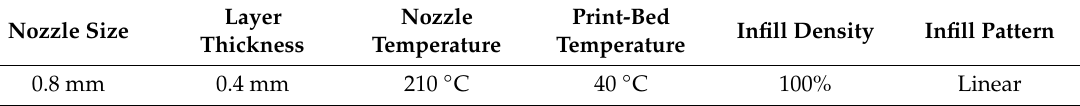
Table 1. The printing parameters for the fused deposition modeling (FDM) printer.